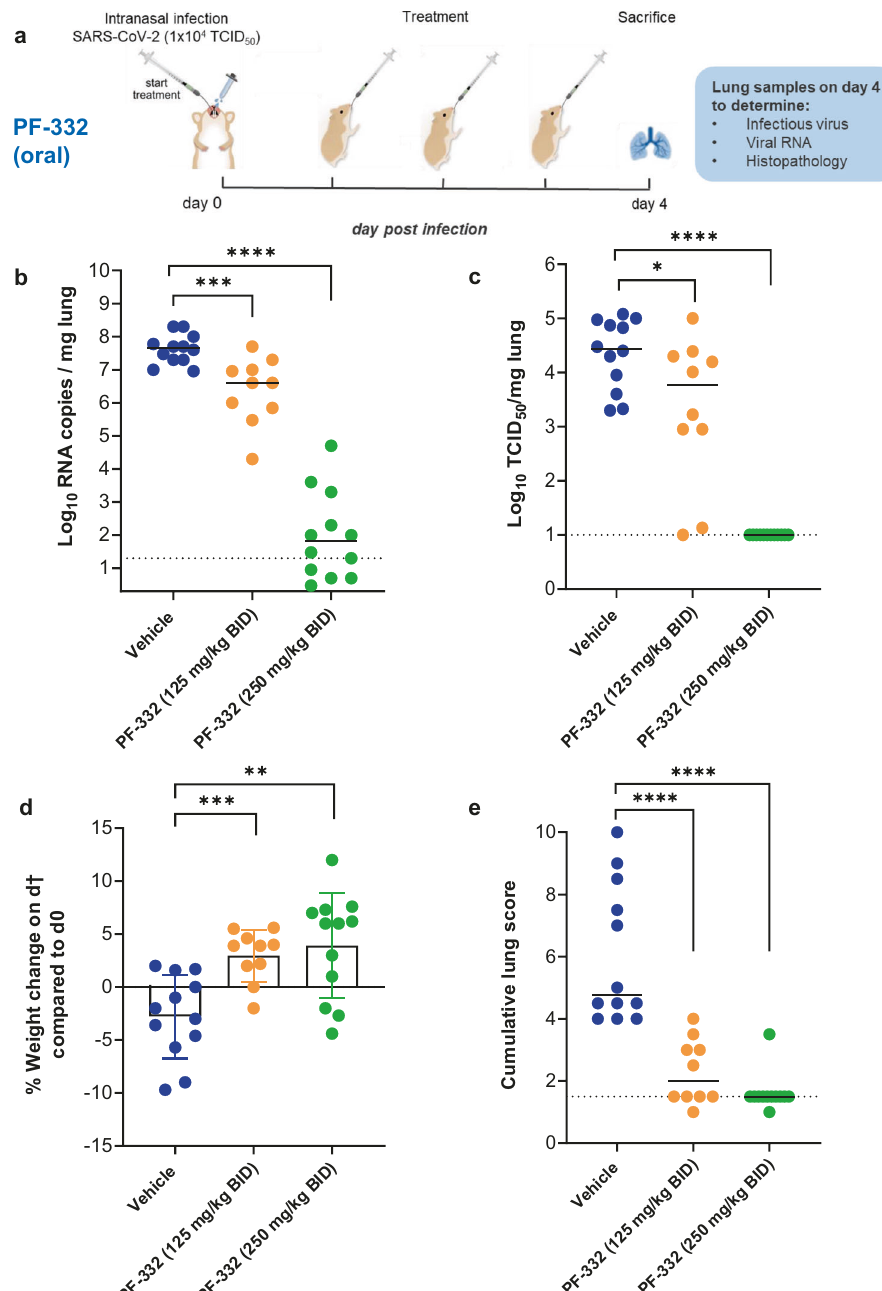
Fig. 2 In vivo ef fi cacy of PF-332 against Beta SARS-CoV-2 (B.1.351) variant in Syrian hamsters. a Design of the study. b Viral RNA levels in the lungs of control (vehicle-treated) and PF-332-treated (at 125 or 250 mg/kg, BID) SARS-CoV-2 − infected hamsters at day 4 post-infection. Individual data and median values (indicated by bars) are presented and are expressed as log 10 SARS-CoV-2 RNA copies per mg lung tissue. Data were analyzed with the Mann – Whitney U test (two-sided). *** P = 0.0007, **** P < 0.0001. c Infectious viral loads in the lungs of control (vehicle-treated) and PF-332-treated SARS-CoV-2-infected hamsters at day 4 pi (expressed as log 10 TCID 50 per mg lung tissue). Individual data and median values (indicated by bars) are presented. Data were analyzed with the Mann – Whitney U test (two-sided). * P = 0.034, **** P < 0.0001. d Weight change at day 4 pi in percentage, normalized to the body weight at the day of infection. Bars represent means ± SD. Data were analyzed with the Mann – Whitney U test (two-sided). ** P = 0.0031, *** P = 0.0003. e Cumulative severity score from H&E stained slides of lungs from control (vehicle-treated) and PF-332-treated hamsters. Individual data and median values (indicated by bars) are presented and the dotted line represents the median score of untreated non-infected hamsters. Data were analyzed with the Mann – Whitney U test (two-sided). **** P < 0.0001. All data b – e are from two independent experiments with n = 12 for vehicle and 250 mg/kg BID groups and n = 10 for 125 mg/kg BID group. PF-332 = PF-07321332. Source data are provided as a Source Data fi